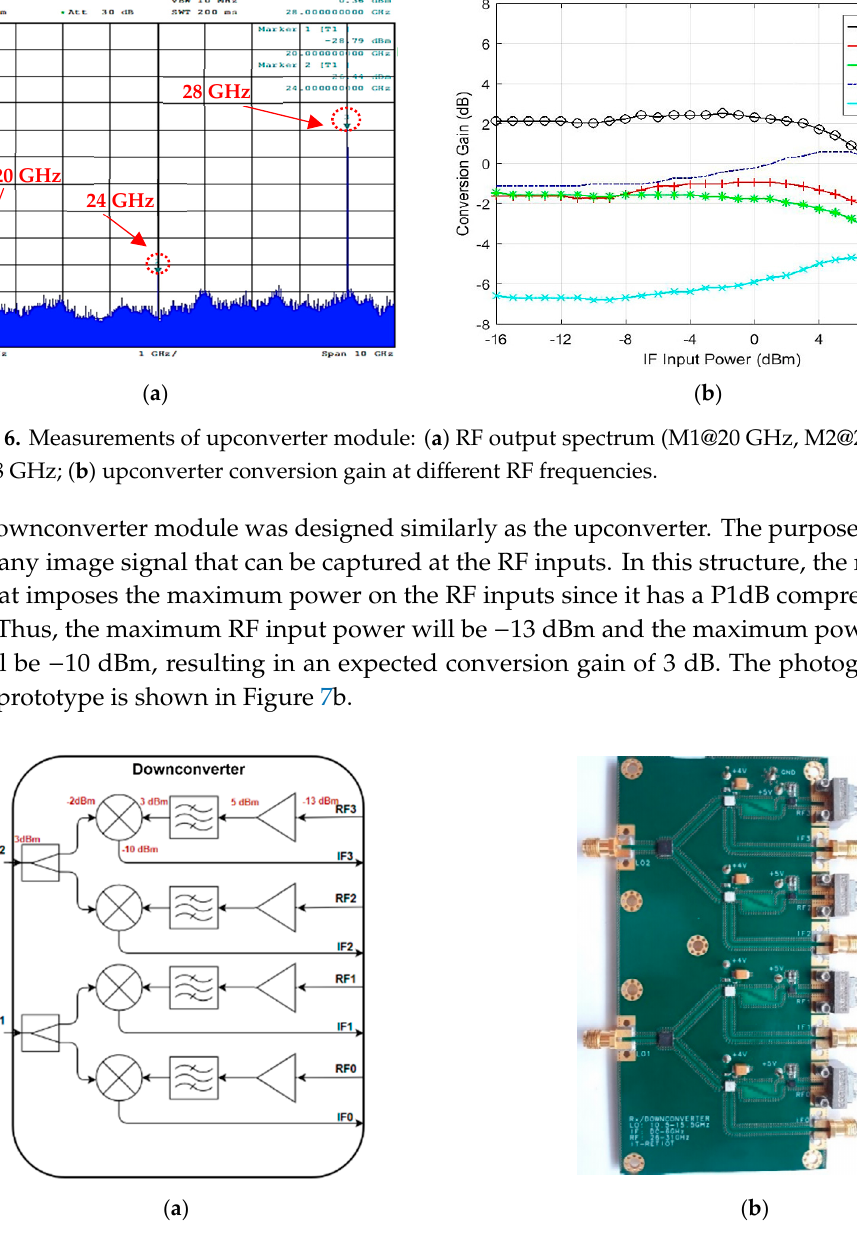
Figure 7. Downconverter designed module: ( a ) block diagram; ( b ) fabricated prototype board.